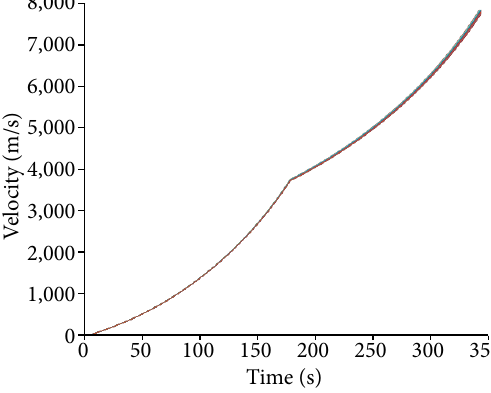
Figure 9. Reducing the effect of uncertainties on SLV velocity with robust optimal design.